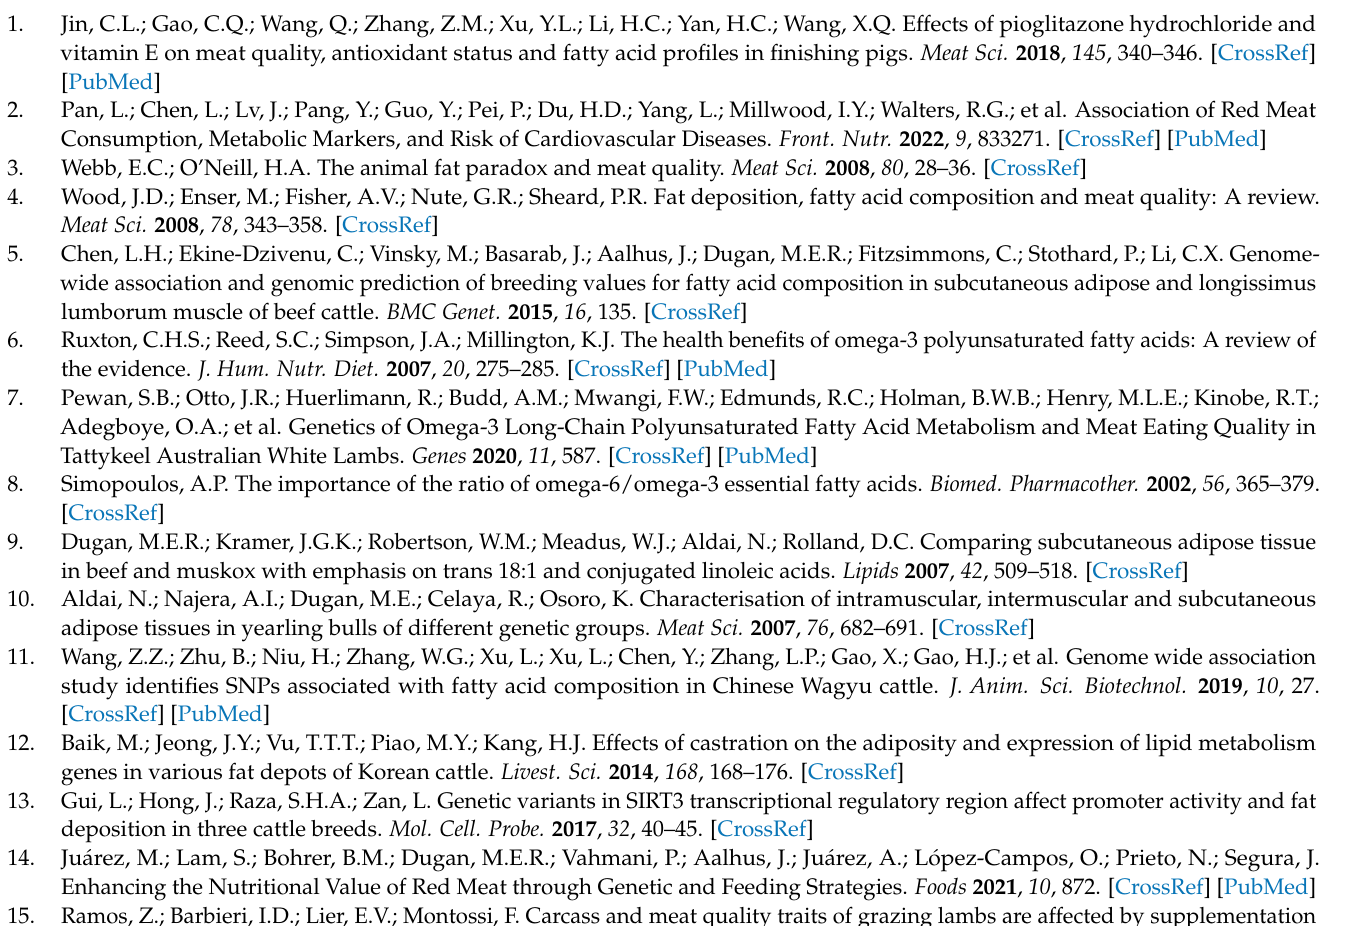
determination. Table S2: The information of total 75 significant differences lipids (SDLs) in yaks longissimus dorsi (LD) muscle between graze feeding (GF) and stall feeding (SF) regimes. Table S3: The information of 17 KEGG pathways enriched by SDLs. Table S4: The information of differentially expressed genes (DEGs) in yak’s LD between GF and SF. Table S5: The information of KEGG pathway enriched by